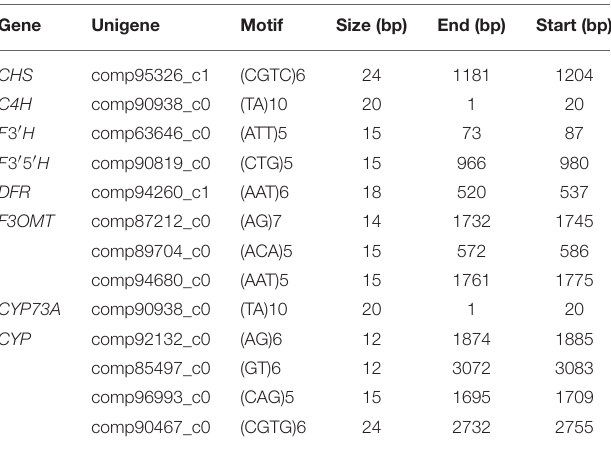
TABLE 2 | SSR motifs in putative genes involved in biosynthetic pathways of flavonoids and stilbenoids. Gene Unigene